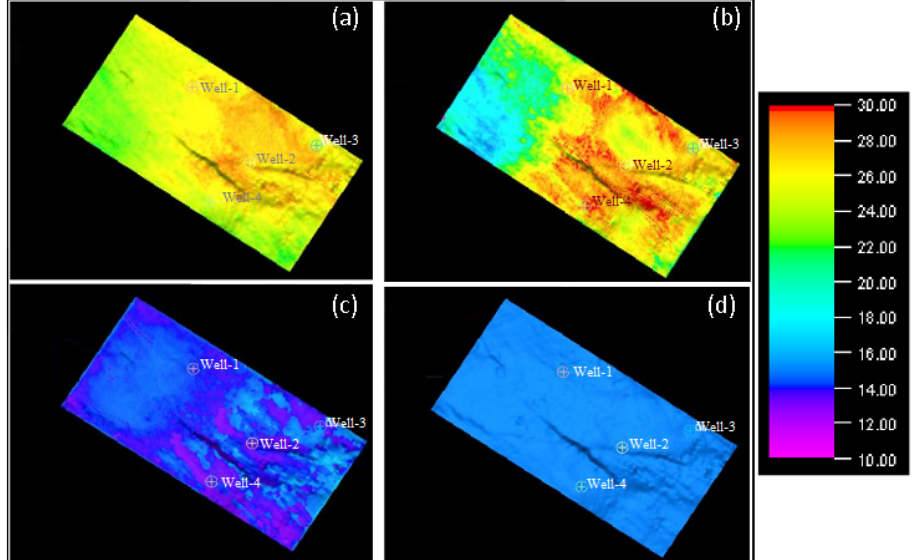
Figure 13. First mud density cubes with 0° inclination and 0° azimuth in lbm/gal for vertical well: ( a ) fracture gradient, ( b ) breakdown, ( c ) breakout, ( d ) kick.